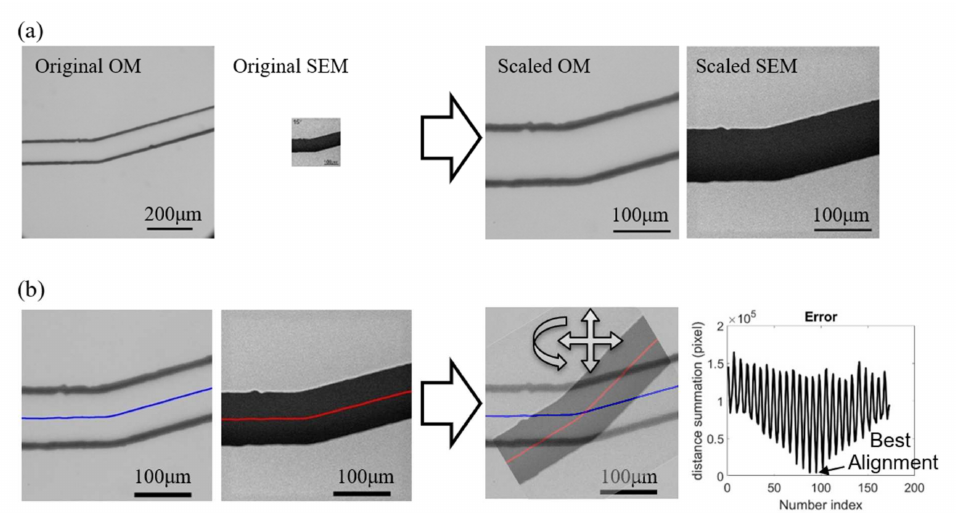
Figure 7. Preprocess for image calibrations. ( a ) Scaling. ( b ) Positioning and rotation.